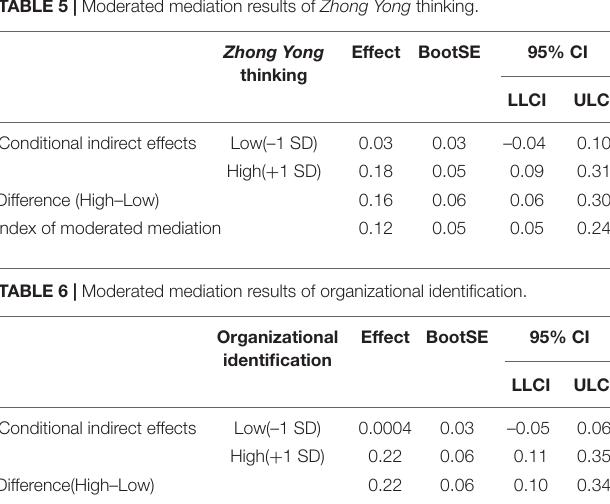
TABLE 5 | Moderated mediation results of Zhong Yong thinking.